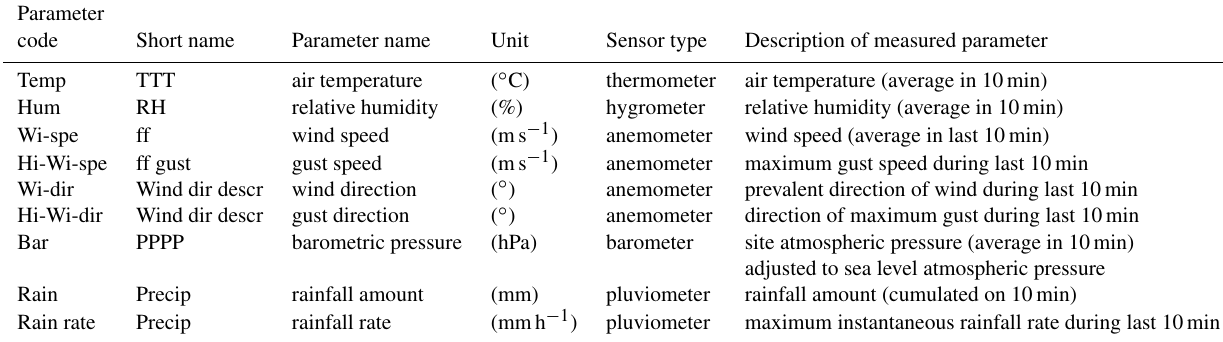
Table 5. List of measured meteorological parameters in DeMSys.